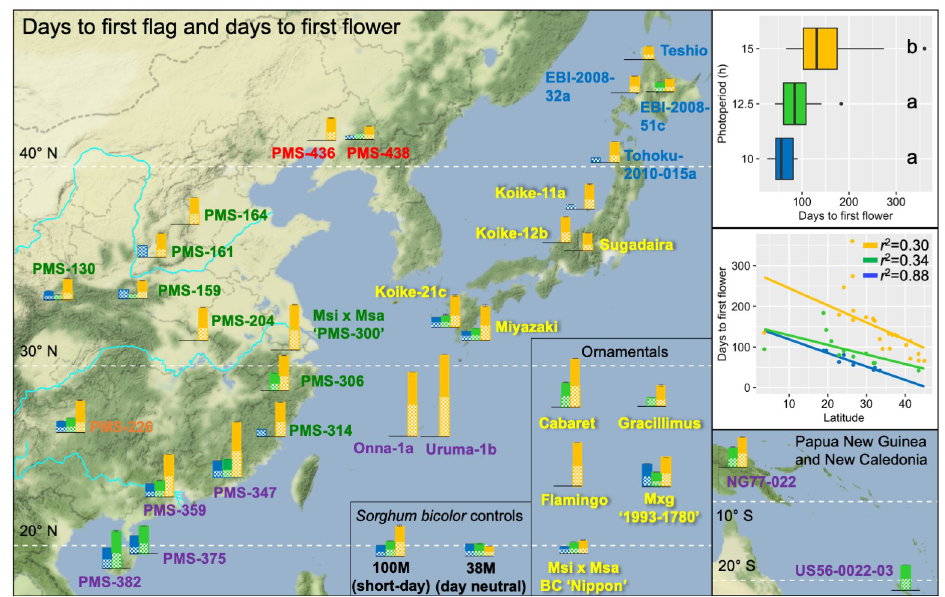
Fig 3. Effects of day length on days to first flag and days to first flower for 33 Miscanthus and two Sorghum bicolor genotypes grown in controlled environment chambers at constant 23 ˚C. The Miscanthus genotypes included 28 M . sinensis , 2 M . floridulus , 2 diploid M . × giganteus , and 1 triploid M . × giganteus . The genotypes were evaluated for response to three day-length treatments: 15 h (orange data), 12.5 h (green data) and 10 h (blue data), respectively. Pattern-filled bars represent days to first flag leaf, and solid-filled bars represent days to first flowering. Note that some Miscanthus genotypes flagged but did not flower. Collection sites of the wild-collected genotypes are shown by their placement on the geographic map. Miscanthus genotype names are printed in colors representing six M . sinensis genetic groups identified by Clark et al . [23, 24], which included Korea/North China (red), Yangtze-Qinling (green), Northern Japan (blue), Southern Japan (yellow), Sichuan Basin (orange), and Southeastern China plus tropical (purple); for interspecific hybrids between M . sacchariflorus and M . sinensis , the dominant M . sinensis genetic group is shown. The inset boxplots depict variation among and within the three day-length treatments; treatments labeled with the same letter were not significantly different based on Tukey’s HSD test at α = 0.05. The inset regression plots show linear relationships between traits and absolute values of latitude at collection sites for the 28 Miscanthus genotypes with geographical information. Note that short days typically advanced flowering up to some optimum, which differed for accessions from different latitudes of origin; higher latitude accessions failed to flower under 10 and 12.5 h, whereas some low latitude accessions failed to flower under 15 h day length. Some M . sinensis accessions from between 20 to 25 ˚N (PMS-226, PMS-359, and PMS-347) responded similarly to the three tested day lengths as the Sorghum bicolor short-day control (100M) but most Miscanthus accessions responded differently in part; all of the Miscanthus accessions responded differently than the S . bicolor day-neutral control